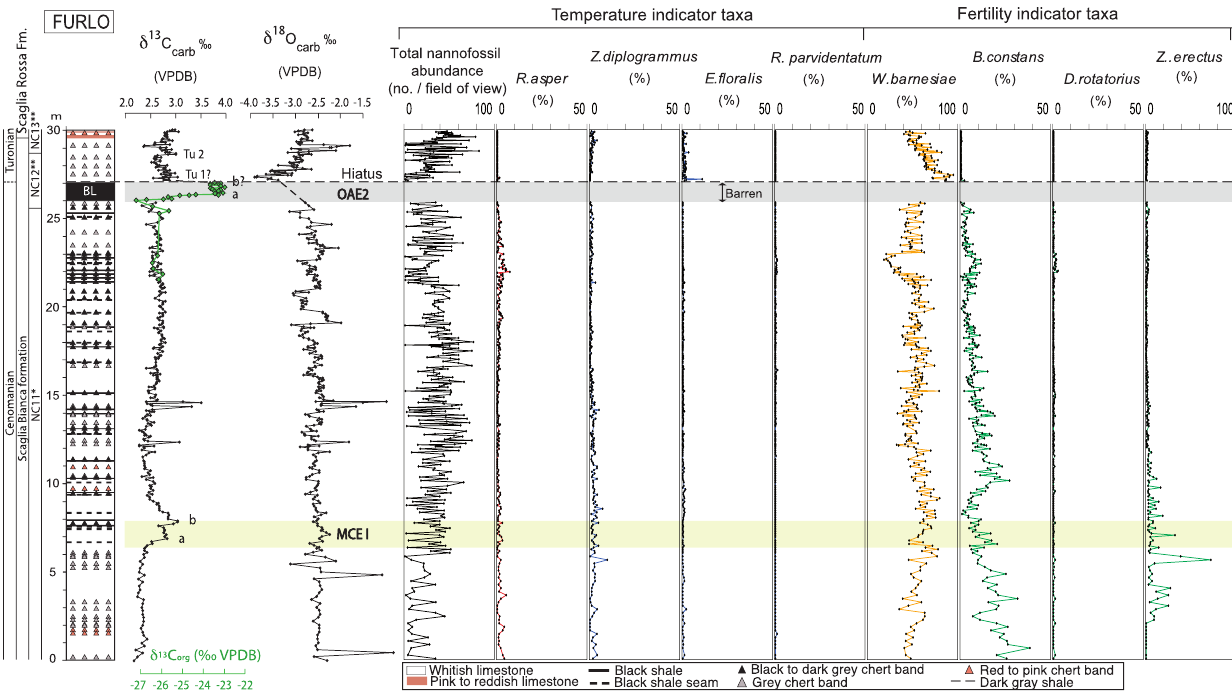
Figure 4. Furlo: total calcareous nannofossil abundance (average number of specimens in one field of view), relative abundance (%) of temperature and fertility indicator nannofossil species. The OAE 2 is indicated by a grey band, the MCE I is represented by a yellow band. The stratigraphic framework (lithostratigraphy, biostratigraphy, chemostratigraphy) is from Gambacorta et al.